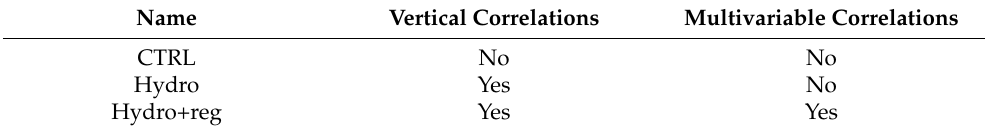
Table 1. Summary of three experiments.